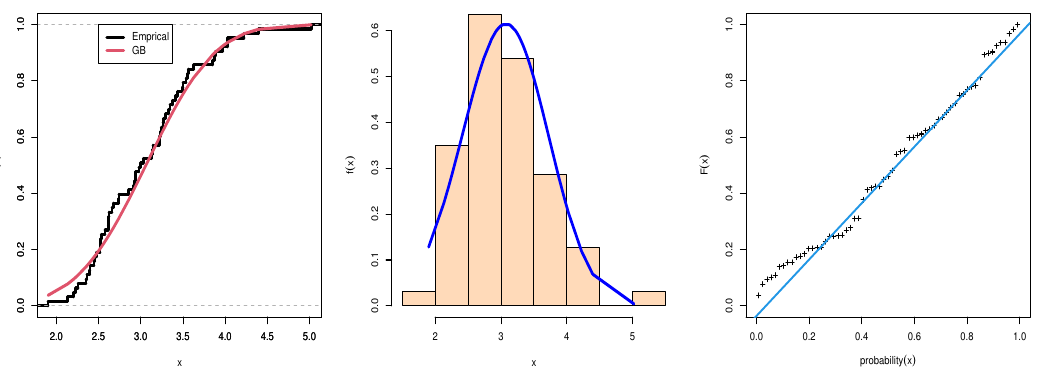
Figure 2. Estimated cdf, pdf and PP-plot of the GB( θ , λ ) distribution when ˆ θ = 3.3869 and ˆ λ = 3.6186. For analysis, we observed random samples of different sizes under the SRS and RSS schemes with different set sizes and number of cycles, computed MLEs of the parameters, K-S statistic, and p -value for the observed SRS and RSS schemes in each case, and compared the performance of the estimates.